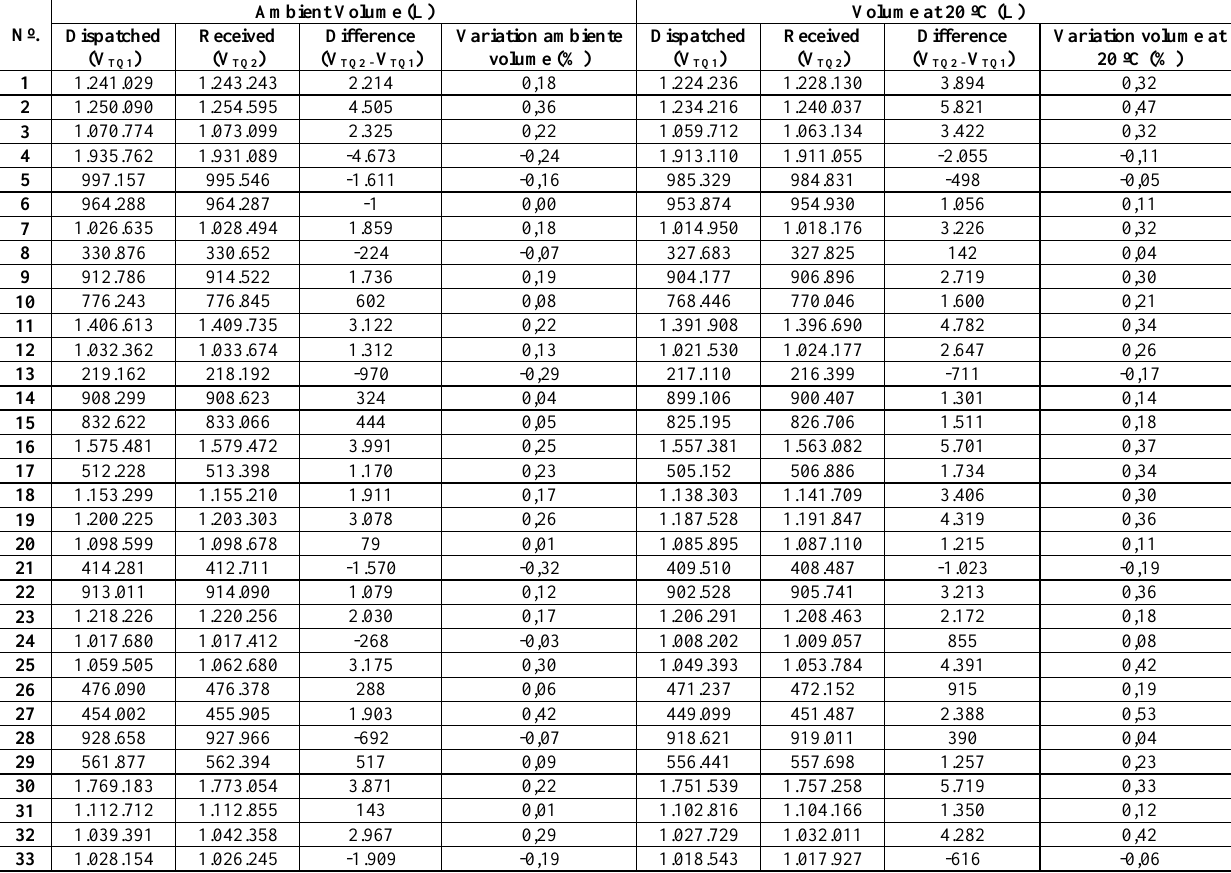
Table 2: Volume variation (%) in transfers between tanks (33 samples - August and September 2020). Nº.